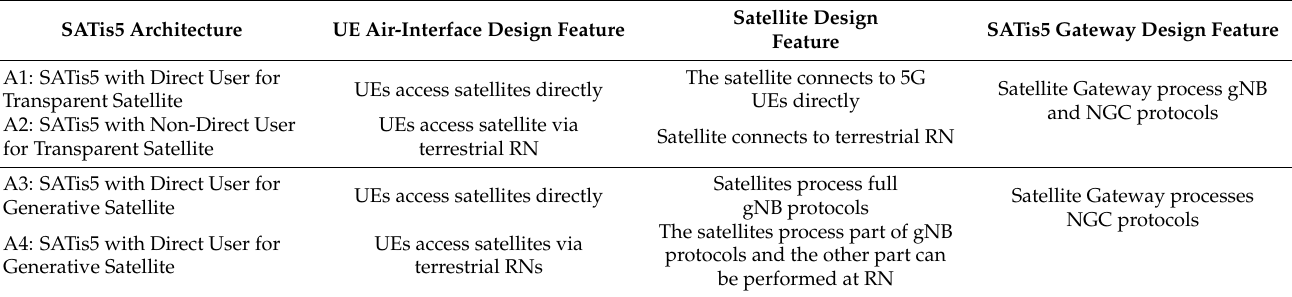
Figure 5. SATis5 Single-Hop and Multiple-Hop Generative Satellite Payload: ( a ) Direct Access SATis5 A3, and ( b ) Non-Direct Access SATis5 A4. Table 3. Design Features Associated with Four Baseline SATis5